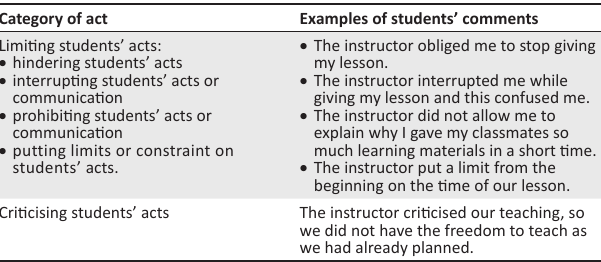
TABLE 2 : Pedagogic acts lessening freedom.